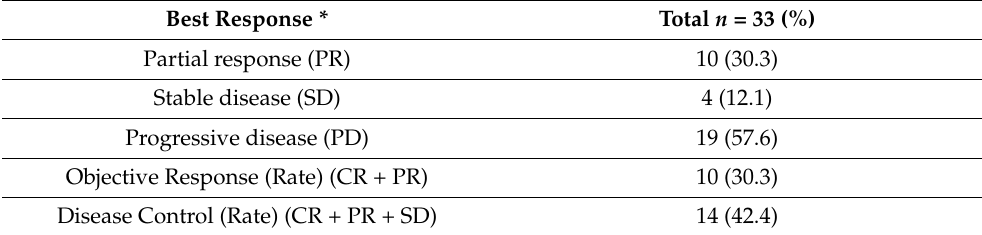
Table 2. Response to treatment with the immune checkpoint inhibitor.